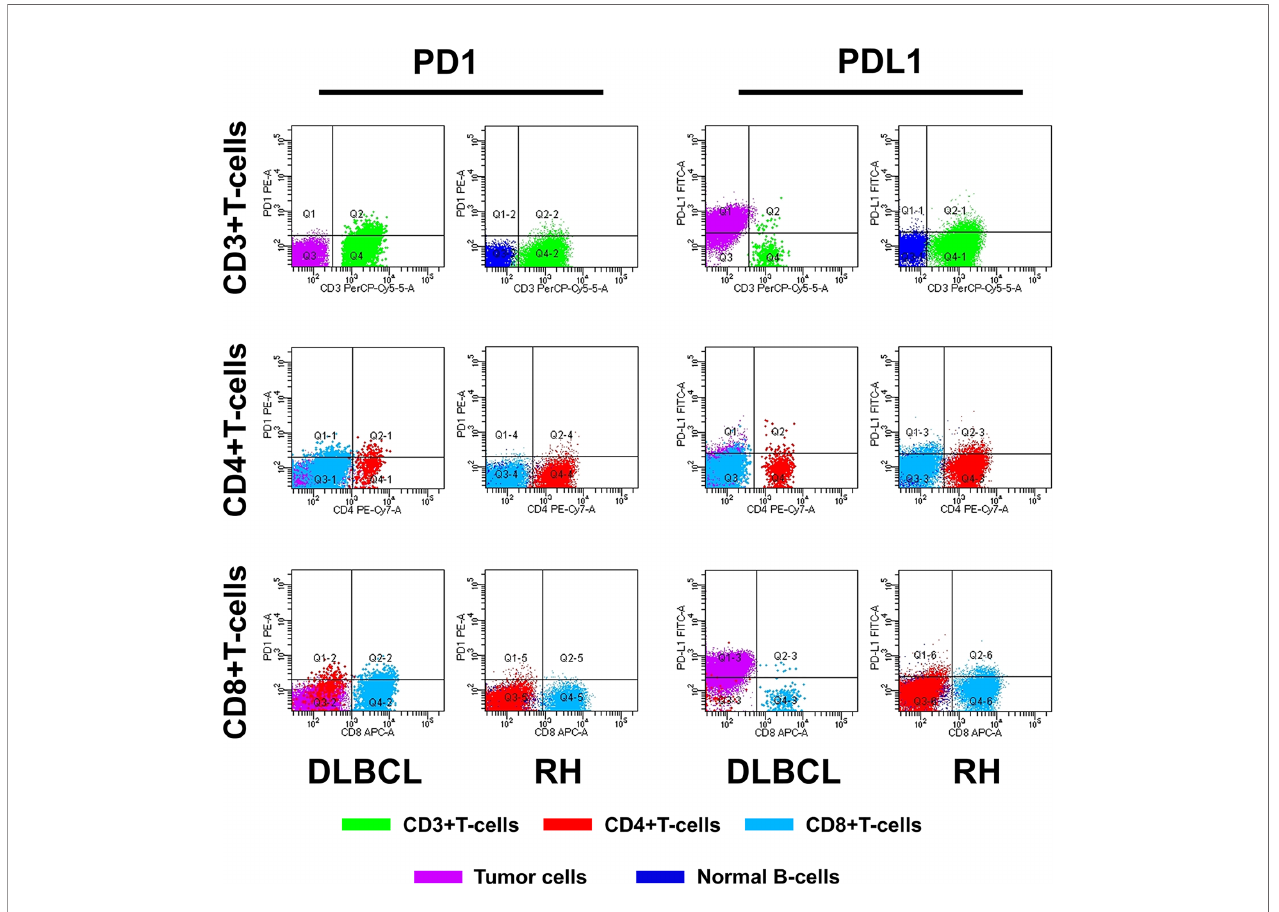
FIGURE 1 | Flow cytometry analysis of PD1/PDL1 status in TILs and normal immune cells.